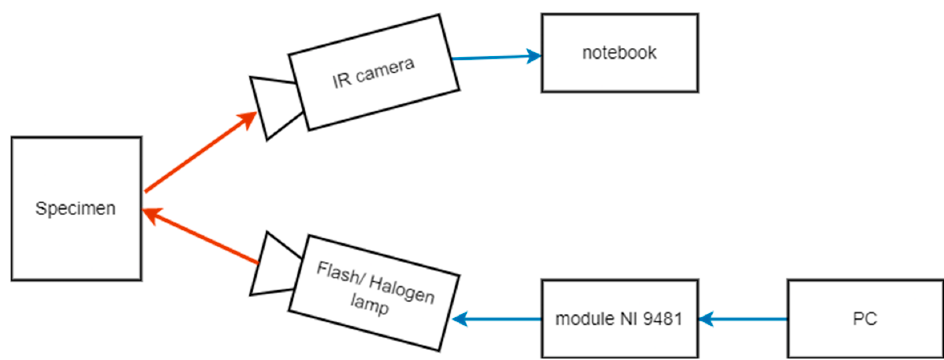
Figure 2. Experimental con fi guration of a lock-in thermography